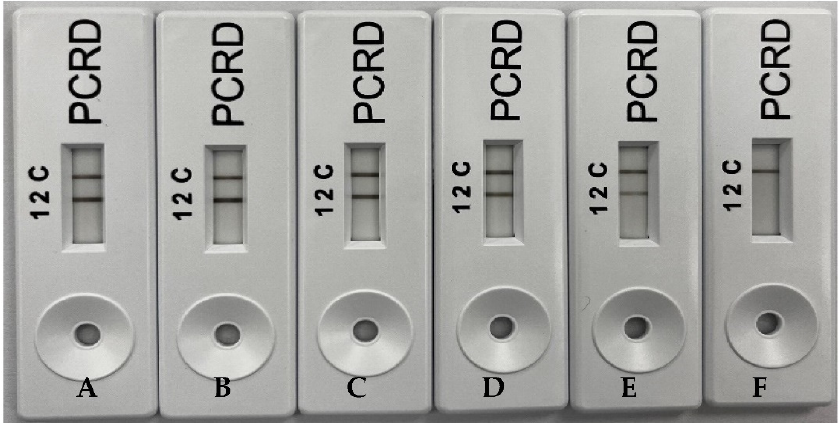
Figure 5. Sensitivity test of RPA-NALFIA assay for adulterated meatballs; (( A ) 100%, ( B ) 50%, ( C ) 10%, ( D ) 1%, ( E ) 0.1%, and ( F ) 0% pork meatball in beef meatball).